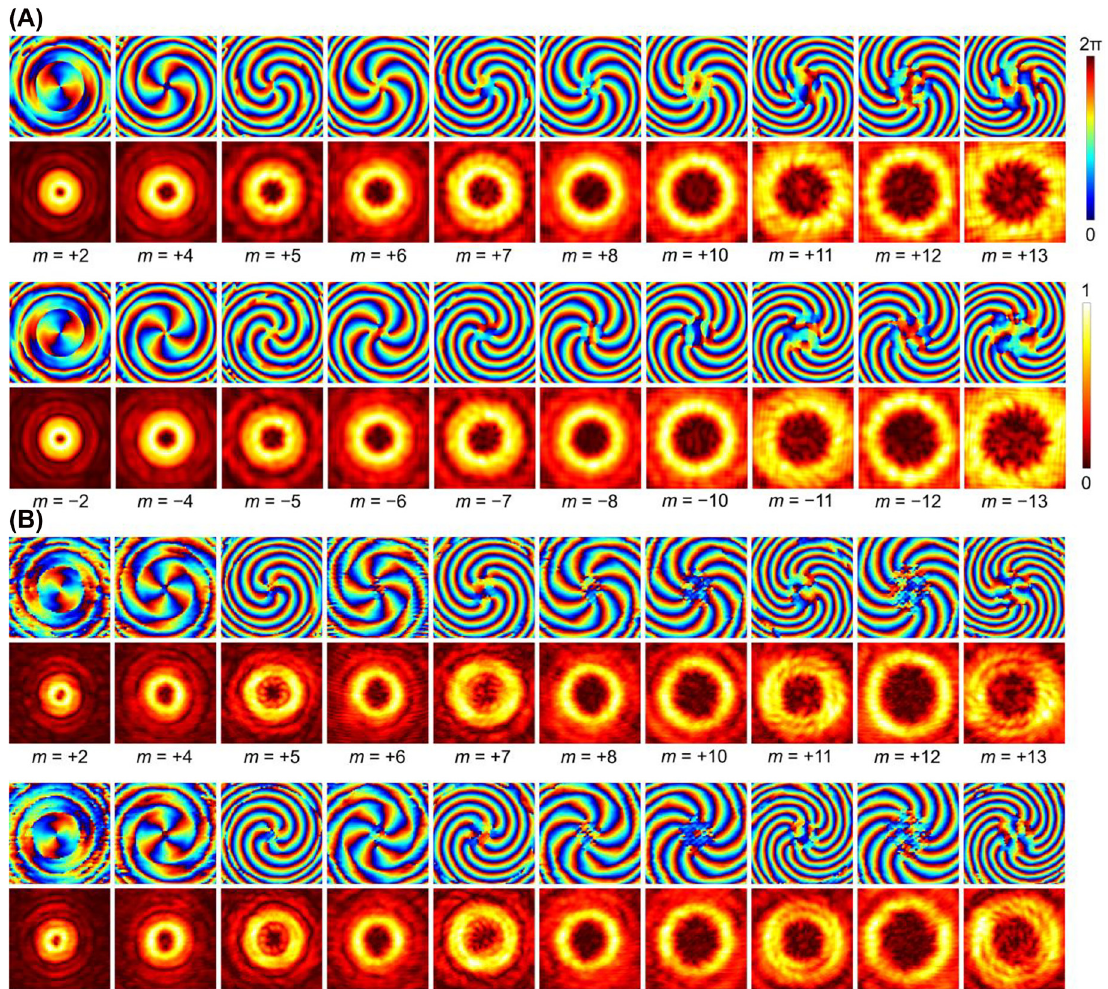
Figure 4: Obtained phase and amplitude results of 20 vortex modes at 50 GHz implemented by cascading the three engineered BVGs according to the method given in Figure S1. (A) Simulated and (B) experimentally measured phase pro fi les and amplitude distributions. The phase pro fi les are plotted in jet colorbar and the amplitude distributions are plotted in hot